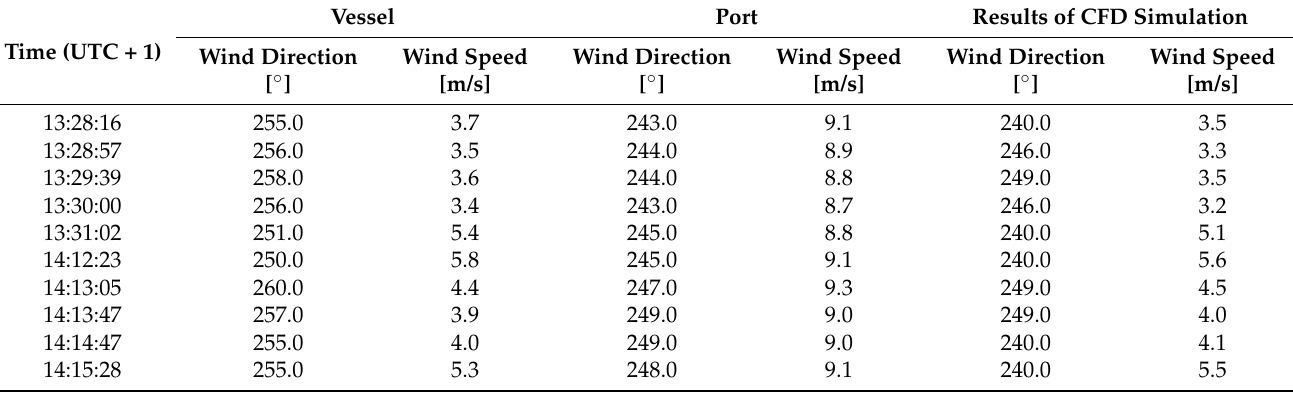
Table 3. CFD simulation results for the height of the port wharf.